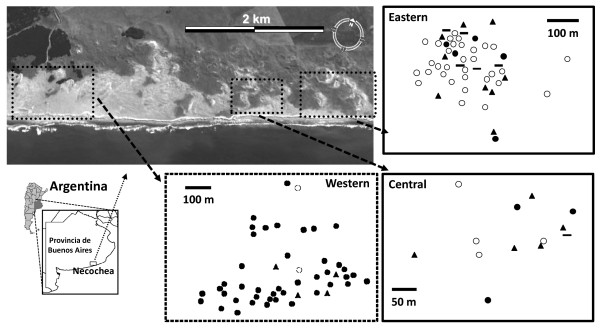
Geographic distribution of Ctenomys australis sampling sites along the study area on the coast. Squares over the map show the surface of each of the three sample sites (Western, Central and Eastern) and their individual points of capture within them (black circles: individuals pertaining to the Western genetic cluster; white circles: individuals pertaining to the Eastern genetic cluster; lines: extra-cluster immigrants; triangles: ambiguous individuals).